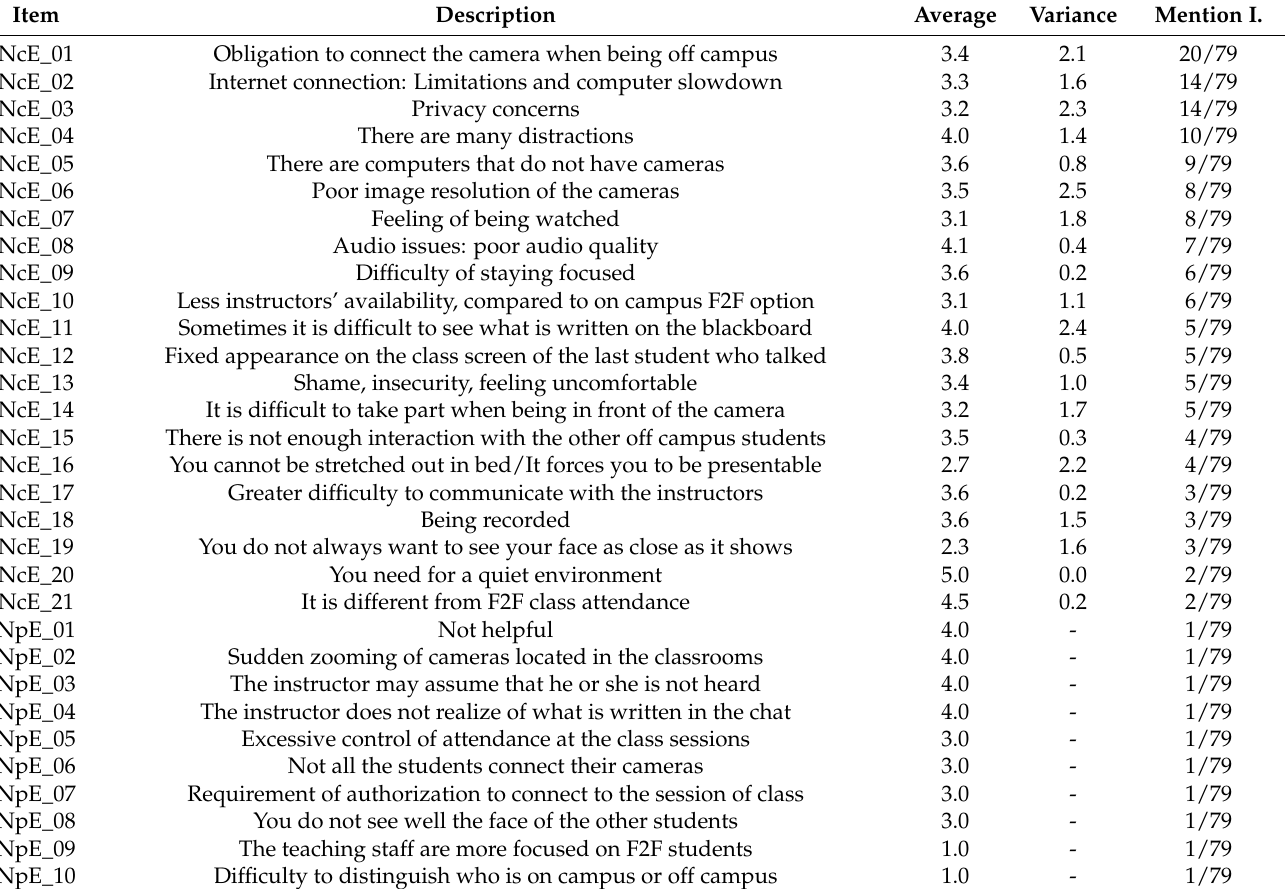
Table 2. Negative (P) common (c) and particular (p)